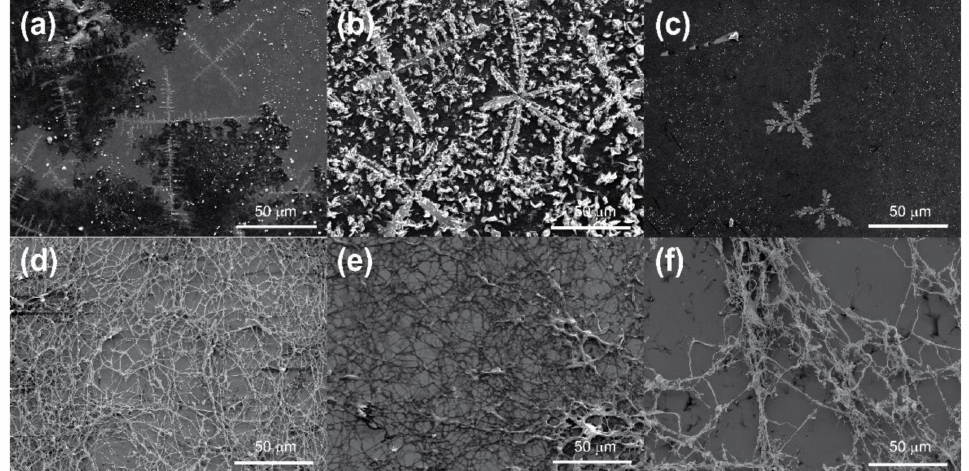
Figure 2. Scanning electron micrographs of 0.1 wt.% air-dried solutions of ( a ) chitosan, ( b ) alginate, ( c ) CNCs and 0.1 wt.% freeze-dried solutions of ( d ) chitosan, ( e ) alginate and ( f ) CNCs, magnification 1.38 k × ( a – c ), 890 × ( d – f